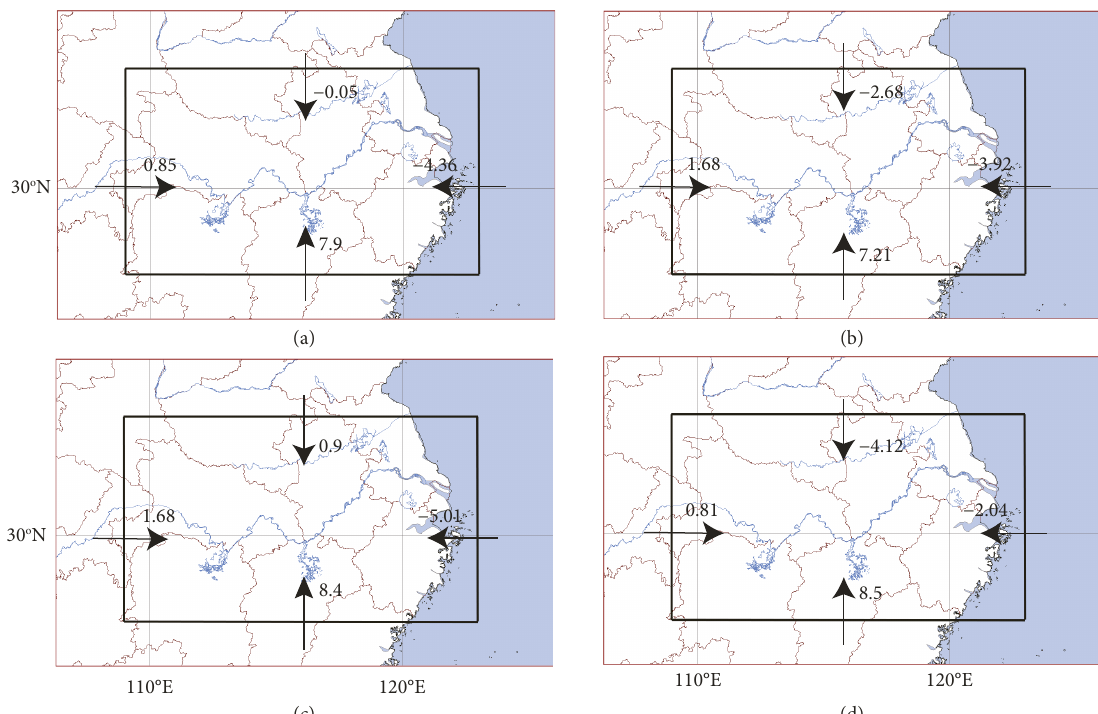
Figure 8: The average vertical integrated water vapor flux on the boundaries of the 4 types of rainstorm cases (unit: 10 7 kg/s). (a) SFP, (b) SHEP, (c) NCVP, and (d)